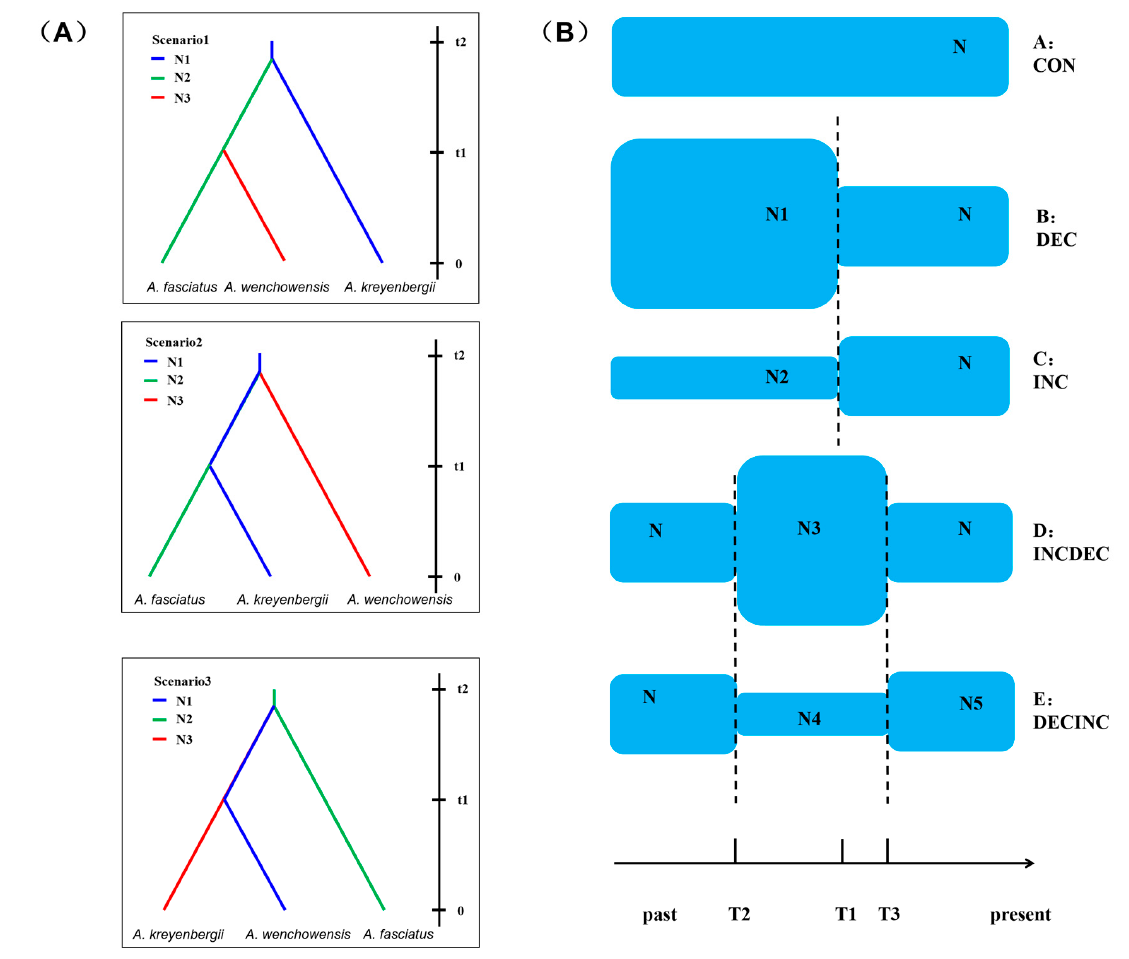
Figure 2. ( A ) Schematic representation of three evolutionary scenarios for A. fasciatus , A. wenchowensis and A. kreyenbergii tested by approximate Bayesian computation (ABC 1). Time and effective population size are not to scale. ( B ) Schematic representation of five demographic scenarios for A. fasciatus and A. wenchowensis tested by approximate Bayesian computation (ABC 2 and 3). Time (T1–T3) and effective population size (N–N5) are not to